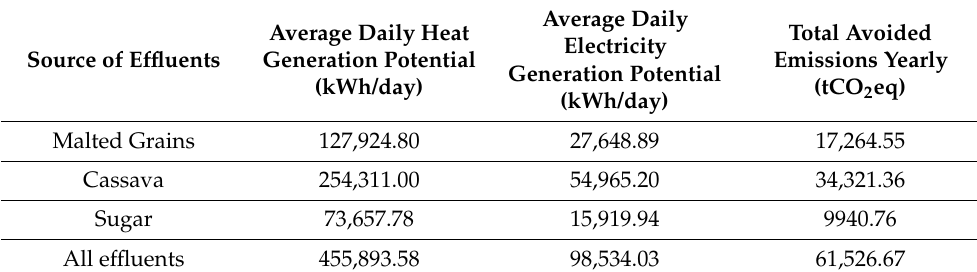
Figure 7. Heat and electrical energy potential from the biogas recovered from the effluents. Table 2. Life cycle assessment of the avoided emissions from generated effluents.